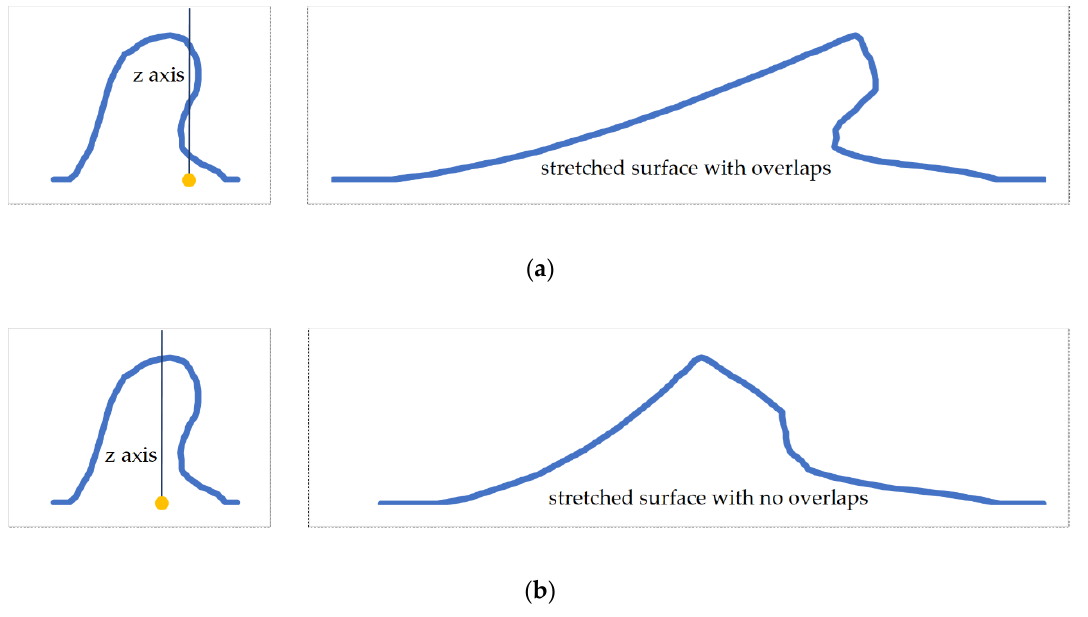
Figure 12. ( a ) Example of a bad choice of origin point (illustrated with yellow color): the resulting surface after the stretching process was applied is shown on the right; ( b ) example of a good choice of origin point (illustrated with yellow color): the resulting surface after the stretching process was applied is shown on the right.